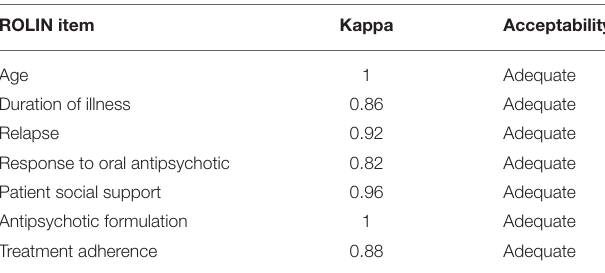
TABLE 5 | Interrater reliability for ROLIN